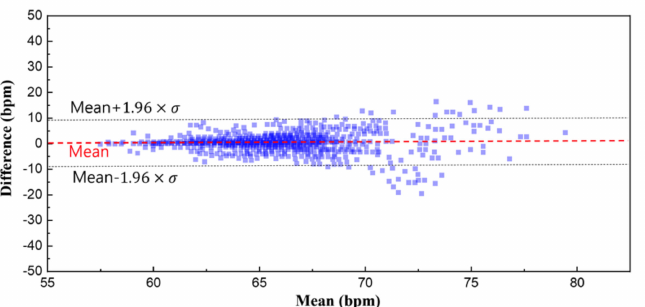
Figure 12. Bland–Altman plot of the heart rate. The overall signal coverage of this work shows an almost perfect overlay compared to the reference instrument within a difference of 0.2 ± 4.65 bpm.